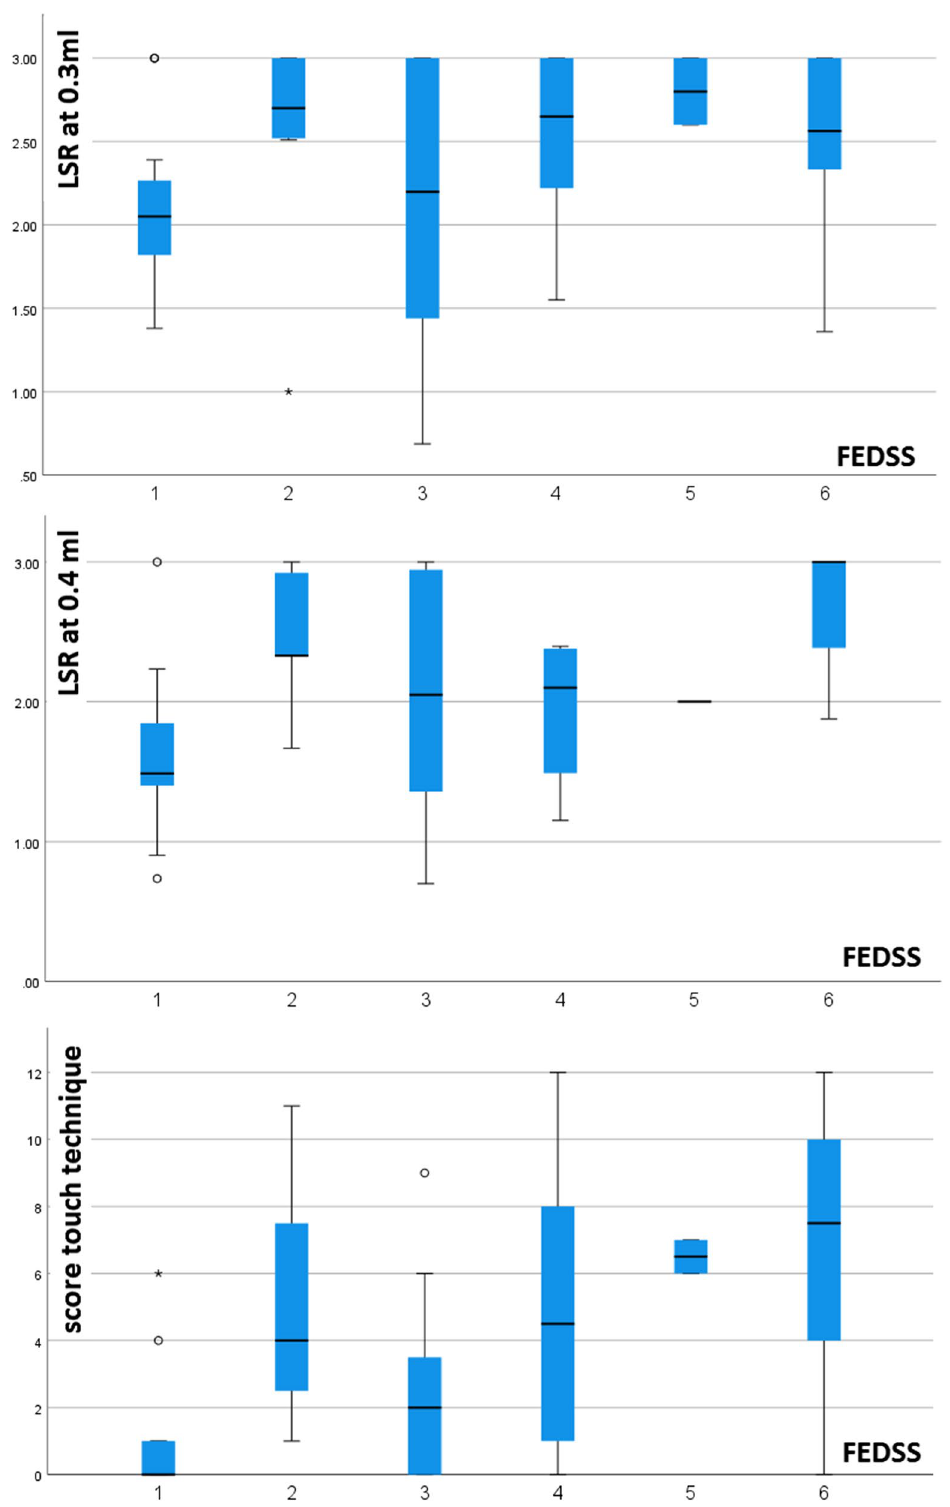
Fig. 2 Distribution of latency of swallowing response (LSR) or touch‑sum score for each Fiberoptic Endoscopic Dysphagia Severity Scale (FEDSS) level visualized in